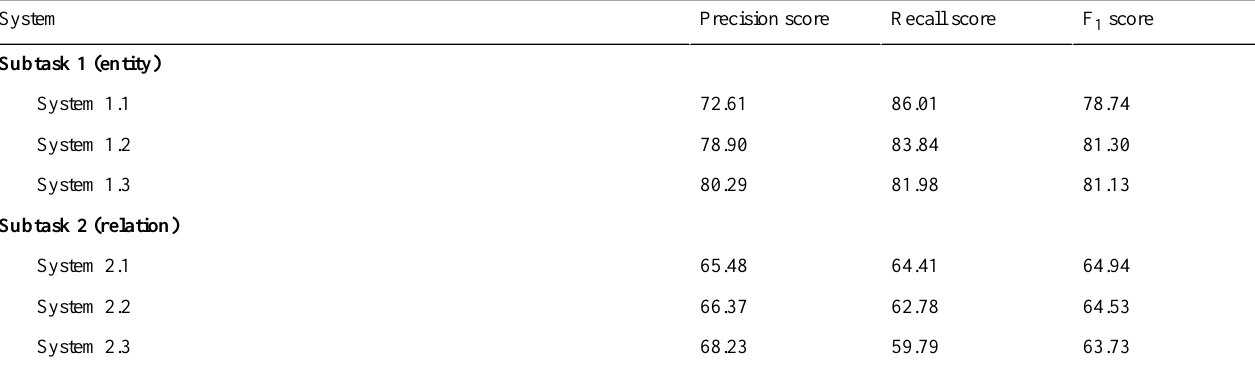
Table 3. Results produced for the 2019 National Natural Language Processing Clinical Challenge (n2c2)/Open Health Natural Language Processing (OHNLP) shared task.